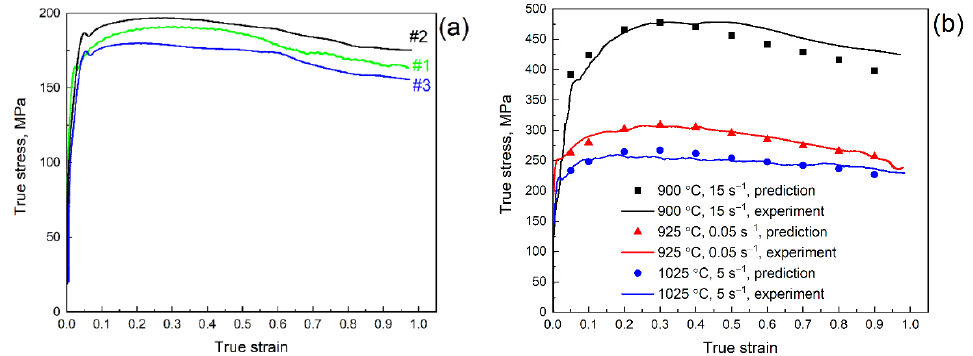
Figure A1. The additional stress-strain curves obtained for determination of the ( a ) reproducibility dispersion ( S 2 y ) and ( b ) adequacy dispersion ( S 2